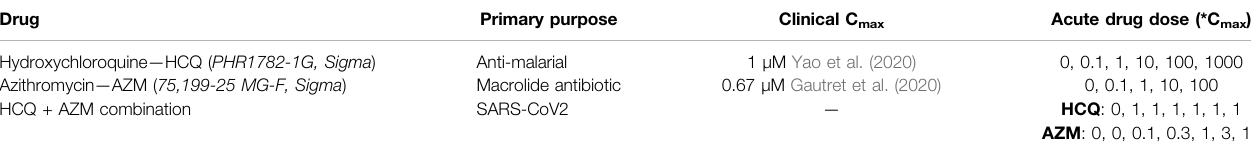
TABLE 1 | Drug and doses used for both acute and chronic exposure.